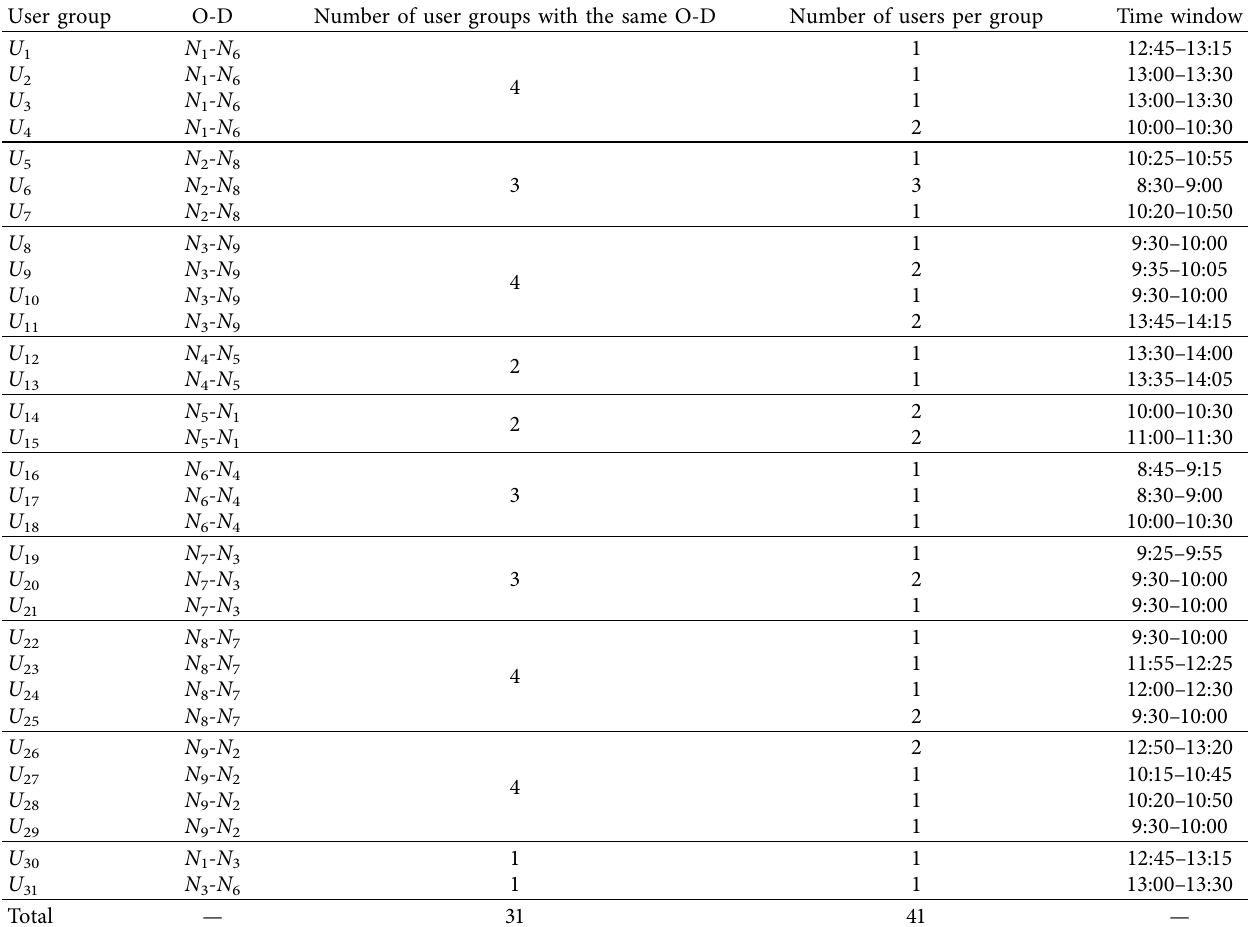
Table 1: User demands. Number of user groups with the same O-D Number of users per group